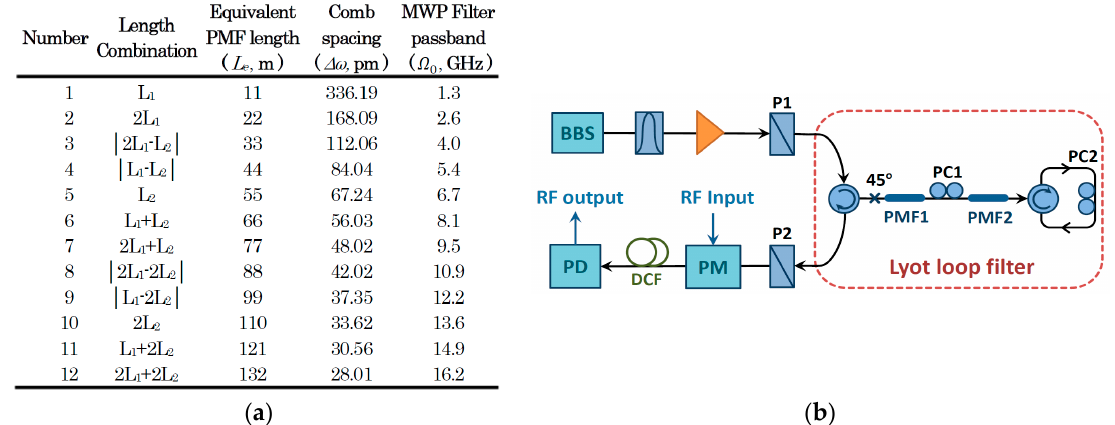
Figure 7. ( a ) Twelve possible combinations of the high-order Lyot loop filter based microwave photonic multiband filter ( L 1 = 11 m, L 2 = 55 m). ( b ) Experimental setup of the reconfigurable microwave photonic multiband filter with twelve passbands based on a high-order Lyot loop filter [33]. BBS: broadband optical source; P1, P2: polarizers; PC1, PC2: polarization controllers;